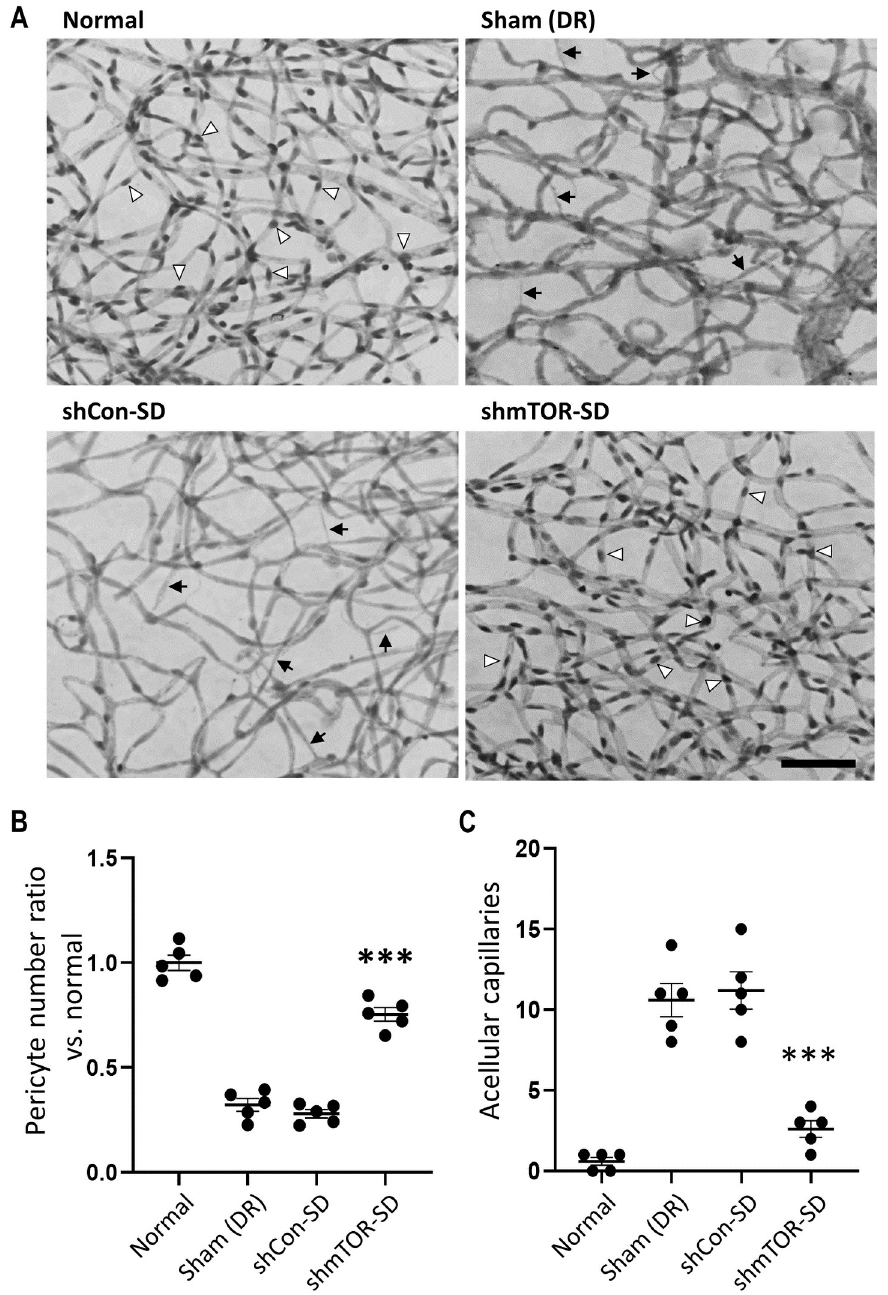
Fig 2. rAAV2-shmTOR-SD reduces retinal pericyte loss. (a) rAAV2-shmTOR-SD administration was shown to protect the diabetic retina against (b) pericyte loss, visualized via white arrowheads, and (c) acellular capillary formation, shown using black arrows, which lead to DR-related vasodegeneration. This early DR process was not observed in normal mice but readily detectable in mice treated with rAAV2-shCon-SD and sham-treated control mice. Scale bar = 50 μ m. Data represented as mean ± SEM (n =